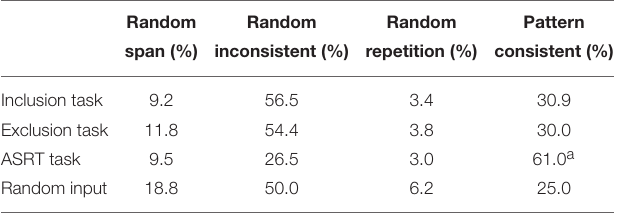
TABLE 6 | Proportion pattern consistent triplets observed and expected by chance.